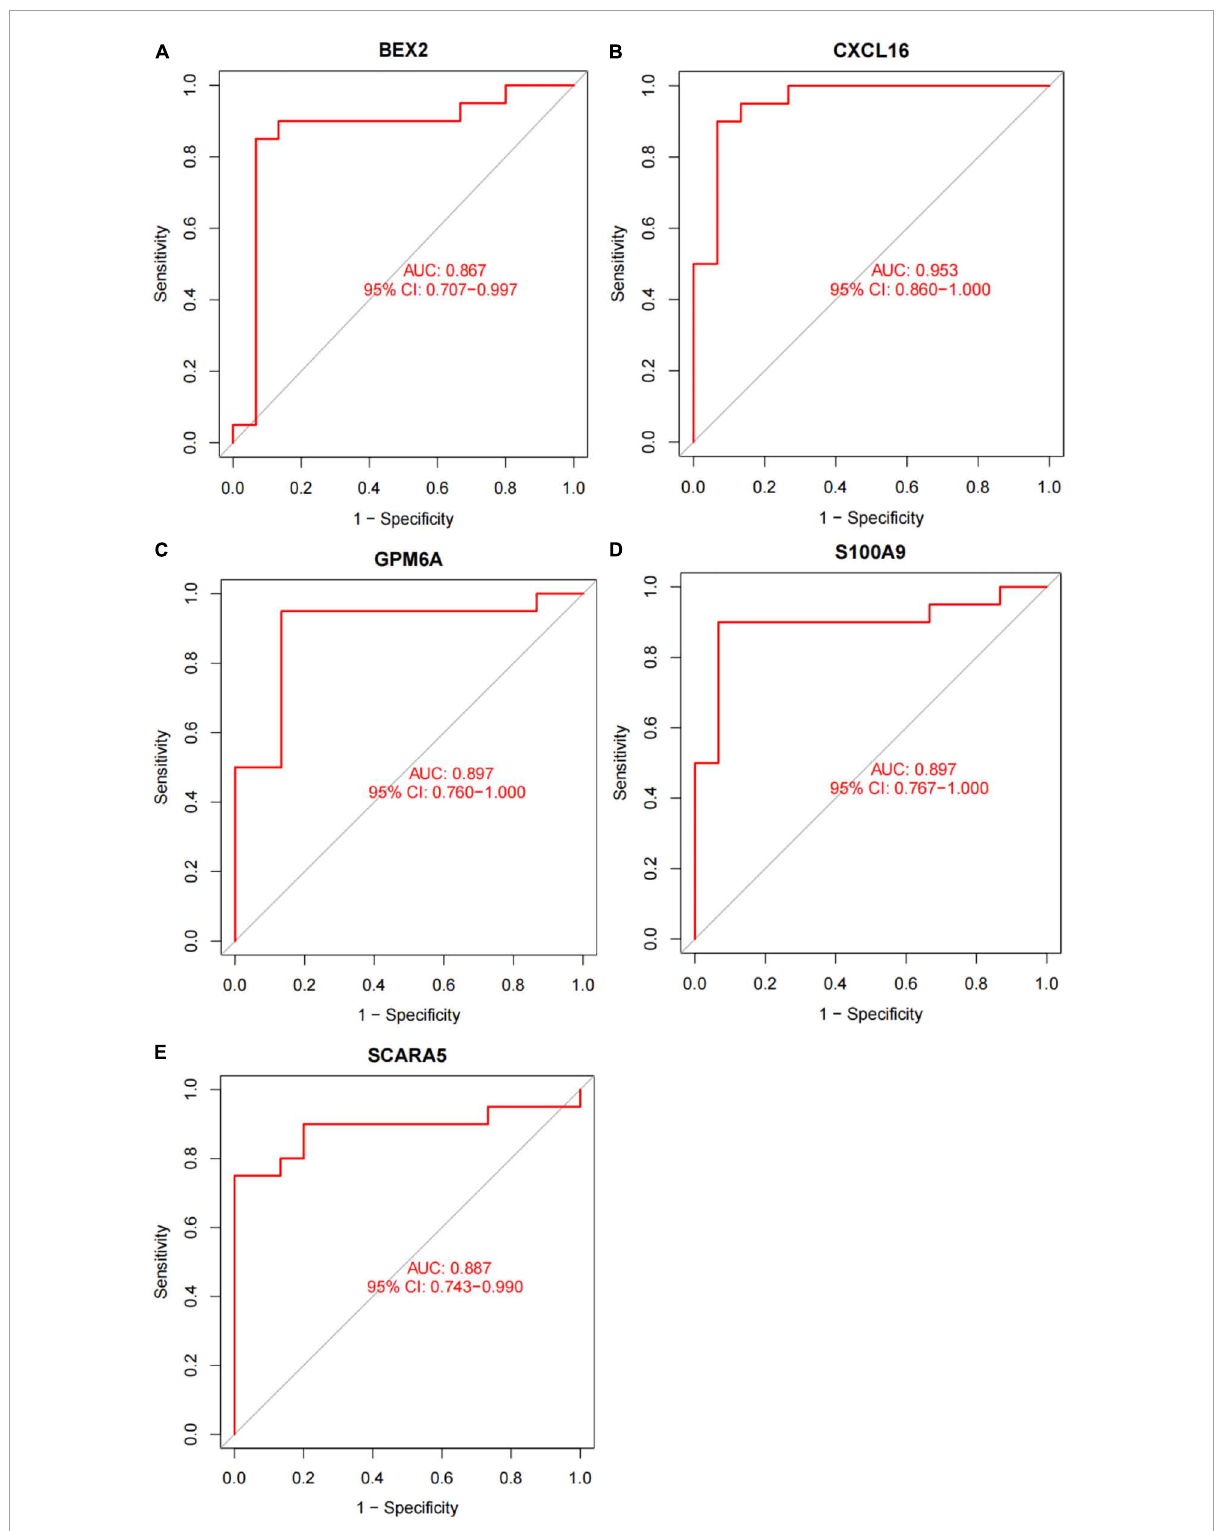
FIGURE7 The diagnostic effect of five markers in the training set. (A) The diagnostic effect of BEX2 in the training set. (B) The diagnostic effect of CXCL16 in the training set. (C) The diagnostic effect of GPM6A in the training set. (D) The diagnostic effect of S100A9 in the training set. (E) The diagnostic effect of SCARA5 in the training set. The points marked on the ROC curve are the optimal threshold points, and the values in parentheses represent sensitivity and specificity. The AUC value is the area under the ROC